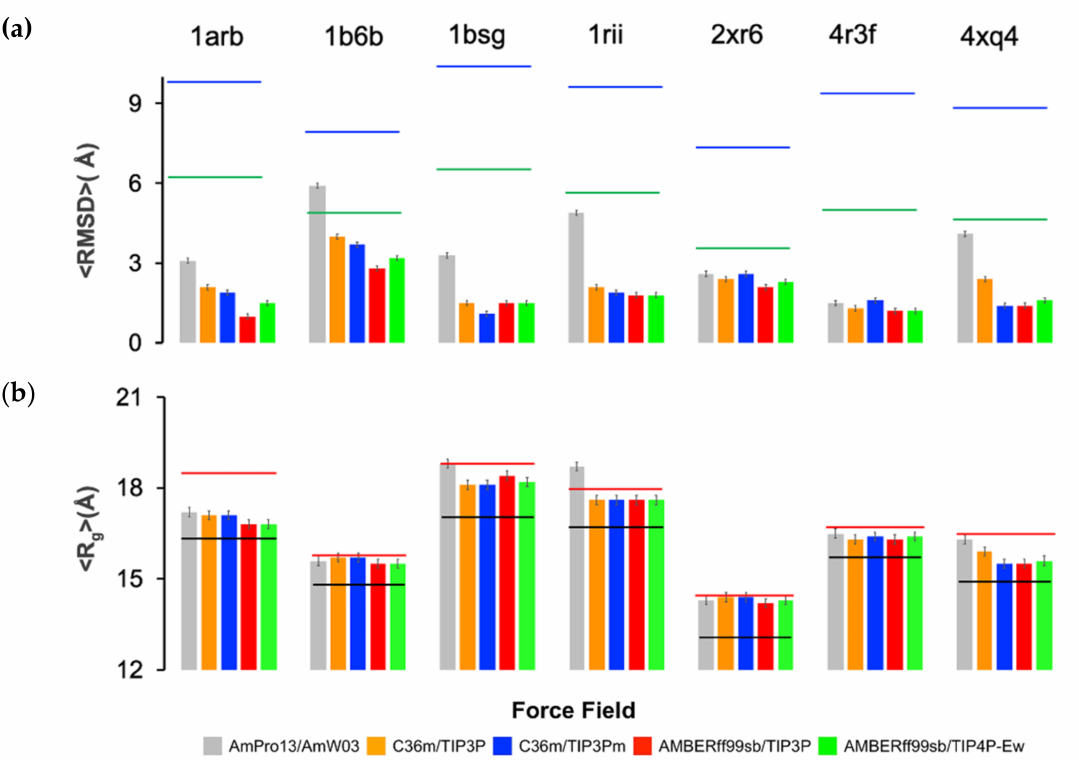
Figure 2. Measures of protein stability when simulated with polarizable and nonpolarizable force fields. ( a ) Root mean square deviation (RMSD) for 1 µ s MD simulations for AmPro13/AmW03, C36m/TIP3P, C36m/TIP3Pm, ff99SB/TIP3P, and ff99SB/TIP4P-Ew. The black line is the value of the D 0, sim metric and the red line the metric and the red line the D 0, dis metric. ( b ) <Rg> for all force fields and comparison to the Rg of the PDB structure (black) or polymer scaling laws (Supplementary Table S2) as a measure of solution (red). Proteins characterized are 1arb [38] 1b6b [37], 1bsg [39], 1rii [40] 4xq4 [43], 4r3f [42] and 2xr6